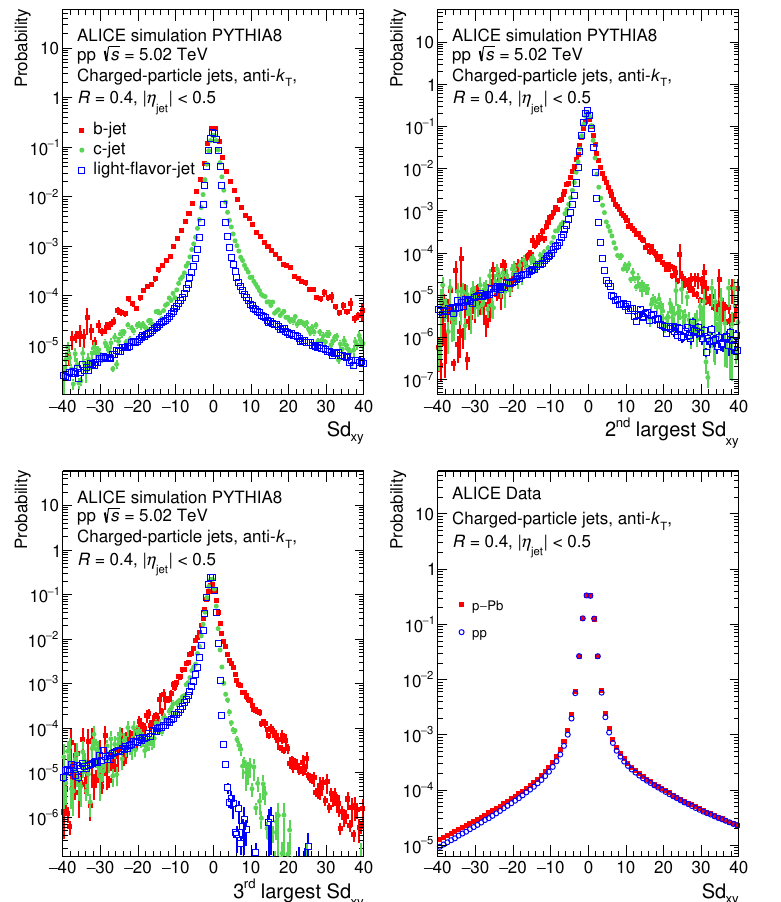
Figure 1. Top left: the normalized impact parameter significance ( Sd xy ) distribution for all tracks inside light-flavor, charm, and beauty jets as determined from PYTHIA 8 (Monash 2013 tune [52]) detector-level simulations. Top right: the distribution of the second largest impact parameter significance in the jet. Bottom left: the distribution of the third largest Sd xy in the jet. Bottom right: distribution of Sd xy for data in pp and p-Pb